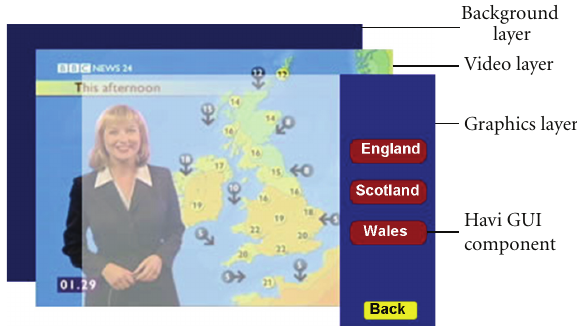
Figure 6: MHP Graphics Layer Model